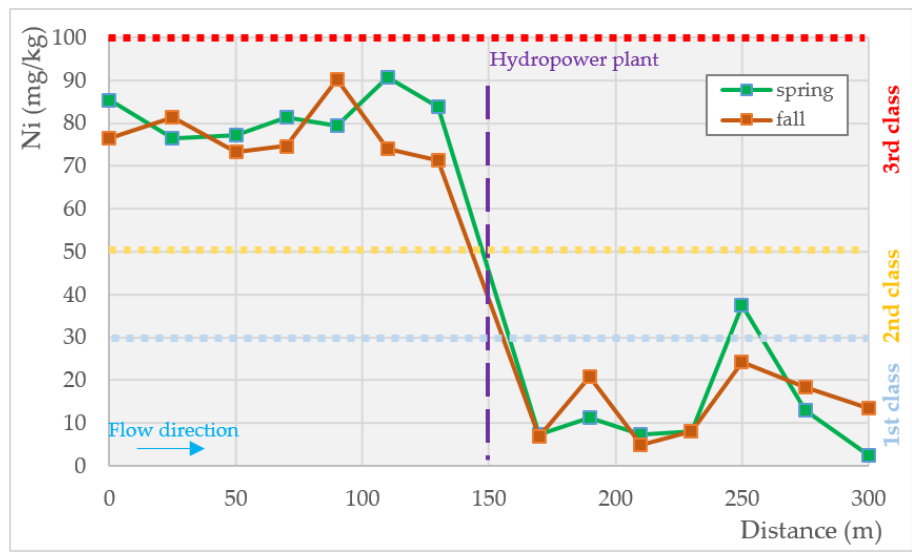
Figure 6. Changes in nickel concentrations in sediments in spring and fall near the hydropower plant on the Ślęza River, along with the geochemical classification.